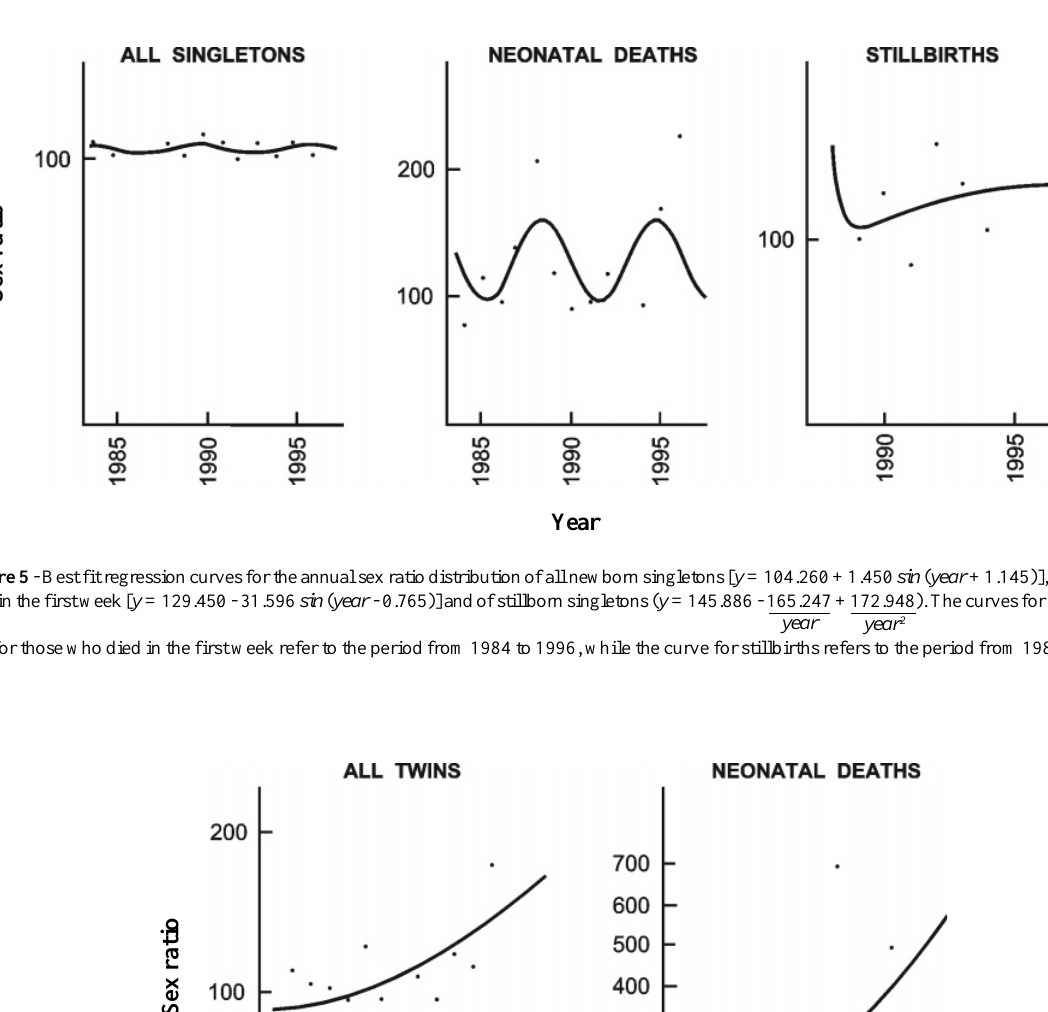
Figure 6 - Best fit regression curves for the annual sex ratio distribution (1984-1996) of all newborn twins ( y = 87.686 + 0.572 year + 0.292 year 2 ) and of those who died in the first week ( y = 124.0 - 5.208 year + 2.448 year 2